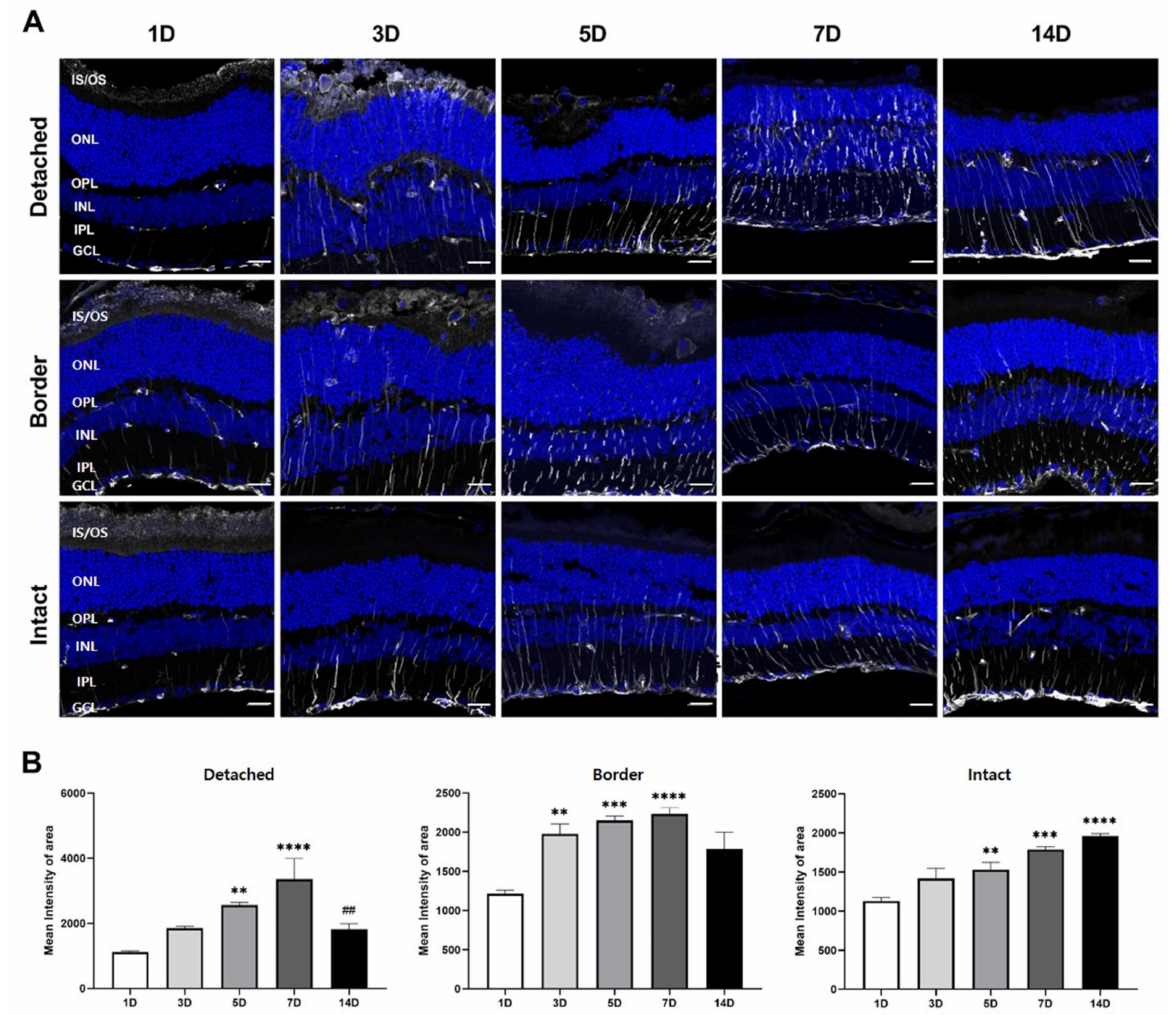
Figure 3. GFAP expression in mouse detached retinas. ( A ) Confocal micrographs of vertical cryosections collected 1, 3, 5, 7, and 14 days after RD. The sections were immunostained with anti-GFAP (white), an activated Müller glial cell marker. In the detached region, GFAP immunoreactivity gradually increased until 7 days after RD, and then decreased. In the border and intact regions, GFAP expression was significantly weak. Scale bars, 20 µ m. ( B ) In each region, ROIs were positioned manually per outer nuclear layer (ONL; n = 6, 15 fields per time point). In the detached region, GFAP expression gradually increased until 7 days after RD ( p < 0.05), after which it significantly decreased ( p < 0.05). In border regions, GFAP levels tended to increase or at least be sustained by 14 days after RD. In the intact region, GFAP expression steadily increased time-dependently ( p < 0.05). Data are shown as mean ± SEM. ** p < 0.01, *** p < 0.001, and **** p < 0.0001 versus 1 day after RD, and ## p < 0.01 versus 7 days after RD, based on one-way ANOVA followed by Bonferroni’s multiple comparisons